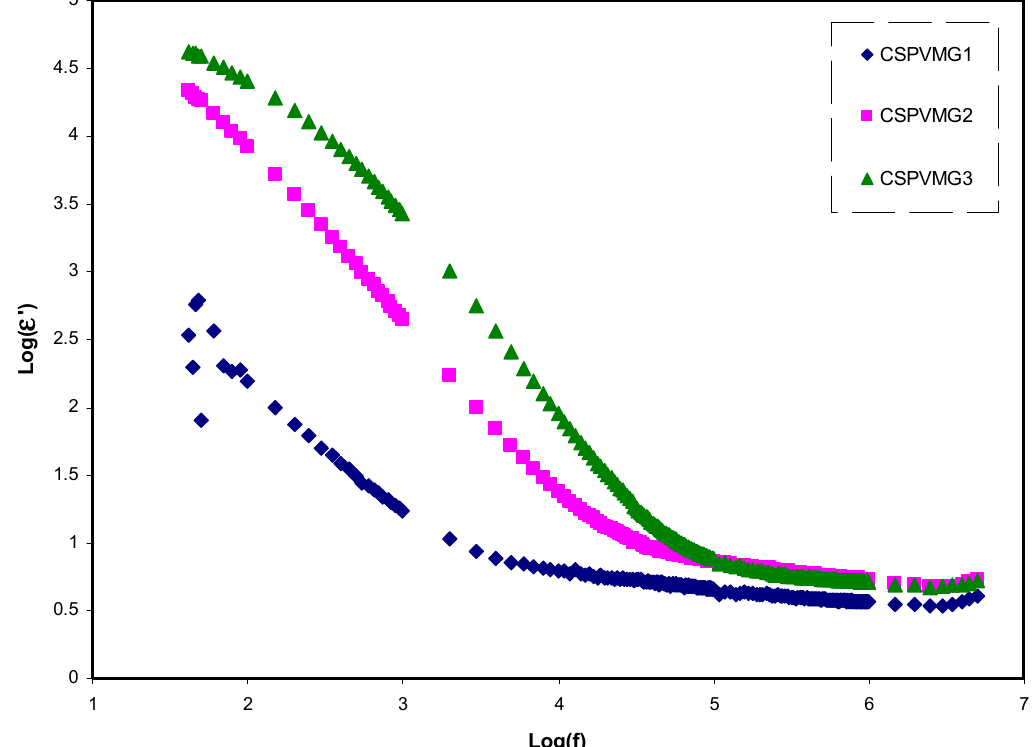
Figure 2. Variation of logarithmdielectric constant ( ε′ ) versus frequency for the CSPVMG1, CSPVMG2, and CSPVMG3 electrolyte samples at ambient temperature.